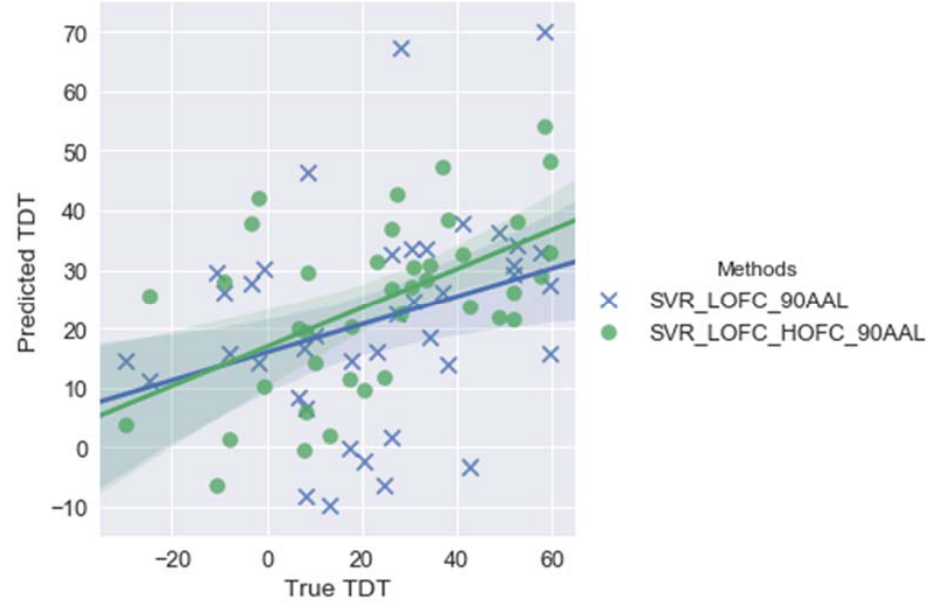
Figure 2. Plots of predicted vs. true Tactile Discrimination Test (TDT) scores by employing support vector regression (SVR) with either LOFC or LOFC + HOFC with feature pools (cerebellum excluded). Correlation coefficients, r , between predicted and true TDT scores are 0.54 and 0.31 for SVR_LOFC_HOFC_90AAL, SVR_LOFC_90AAL, respectively. Note: SVR_LOFC_HOFC_90AAL represents the SVR model using both LOFC and HOFC features based on automated anatomical labelling (AAL) atlas, while SVR_LOFC_90AAL represents the SVR model using LOFC features only based on AAL atlas. LOFC = low-order functional connectivity. HOFC = high-order functional connectivity.